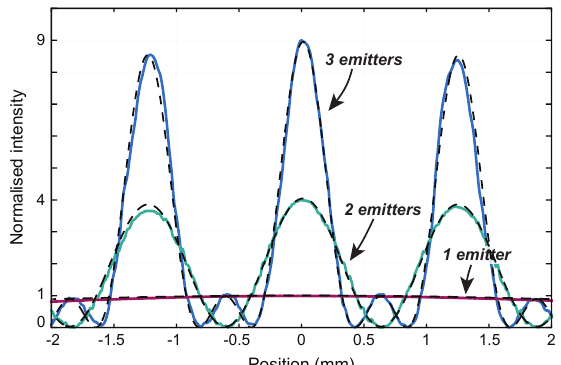
Figure 14. Measured (solid) and simulated (dashed) far field interference profiles for one, two, and three emitter configurations. The beam profiler was located 30 ± 0.5 cm from the OPA.